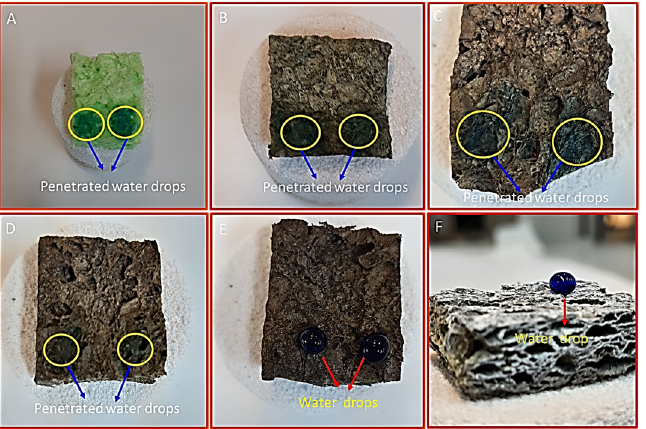
Figure 3. Elemental mapping of the C18s-Ag-DA-Cell-F ( A ) C, ( B ) O, ( C ) N, ( D ) Ag, ( E ) Si, and ( F ) EDX spectrum. Red color indicated C, cyan color O, green N and Ag, and purple color Si.